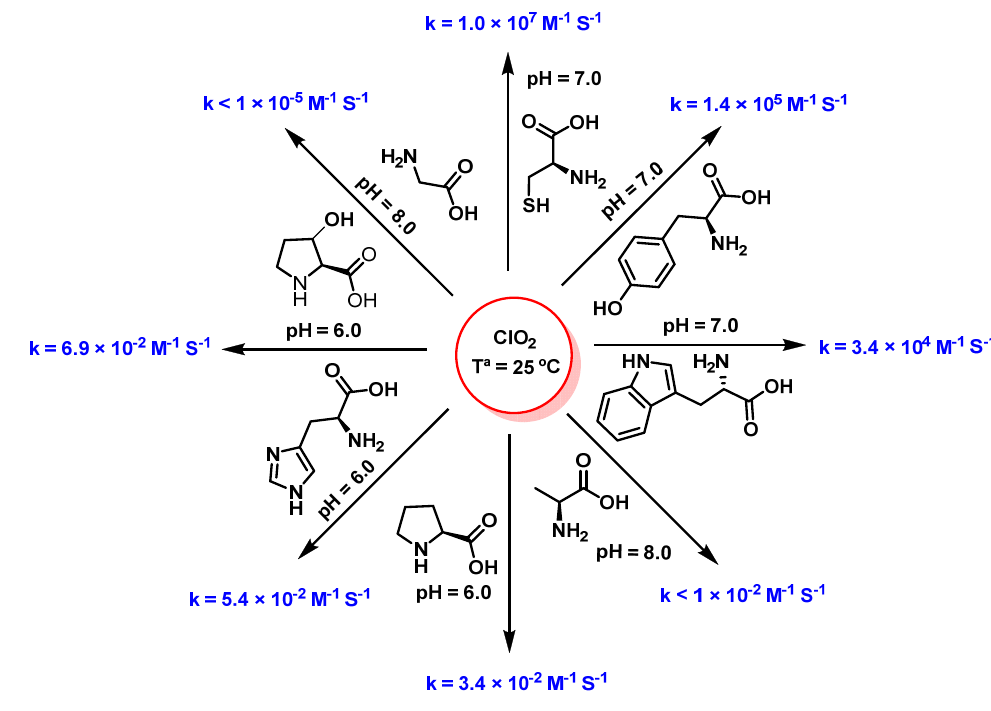
Figure 34. Reaction rate constants of ClO 2 with amino acids at 25 °C [7] .